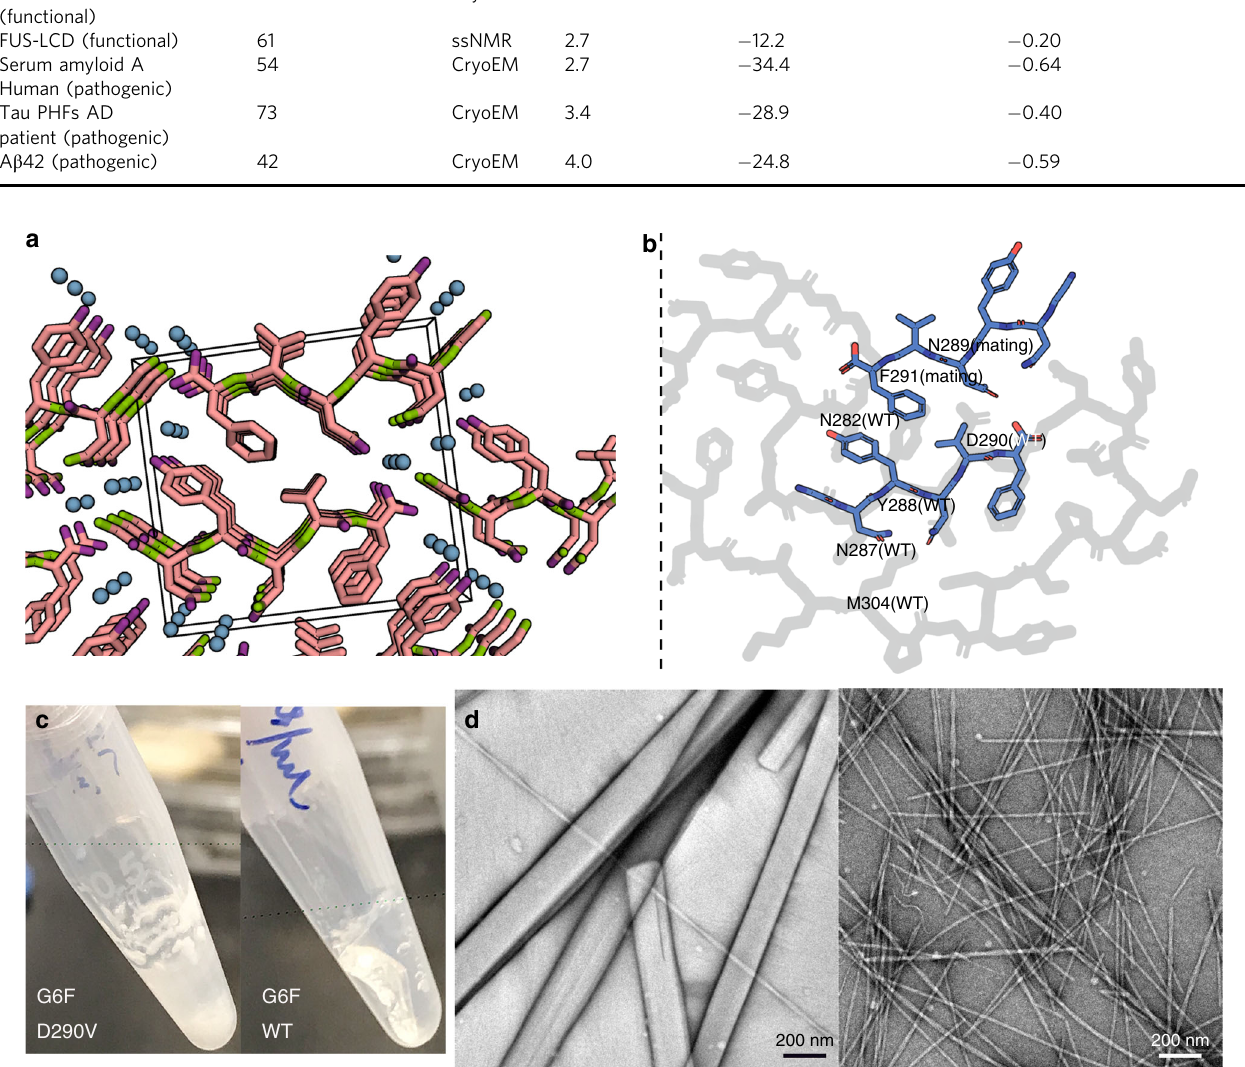
Fig. 4 Mutant core segment and the corresponding wildtype segment show distinct features. a The steric zipper structure determined for mutant segment GNYNVF, viewed down the fi bril axis. Water molecules within the structures are shown as aqua spheres. The unit cell is shown as a box. b A superimposition of the mutant steric zipper structure of GNYNVF (blue) on the cryoEM mC-hnRNPA2-LCD structure (gray) shows the incompatibility of the mutant structure with the fold of the wildtype fi bril. Only the corresponding part of the wildtype structure is shown. The sidechains of Asn287, Tyr288, and Asn289 of the mutant structure experience steric clashes with the sidechains of Asn282, Asp290, and Met304 of the wildtype structure. c Left: Mutant segment GNYNVF shaken after 4 days forms a white precipitate. Right: Wildtype segment GNYNDF shaken after 4 days forms a hydrogel. d Left: The mutant segment GNYNVF (from c ) visualized by transmission electron microscopy, shows wide needle crystals. Scale bar: 200 nm; Right: Wildtype segment GNYNDF (from c ) visualized by transmission electron microscopy, shows thin fi